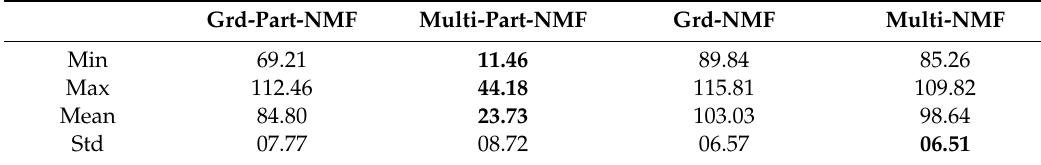
Table 1. Photovoltaic panel NMSE values (%).